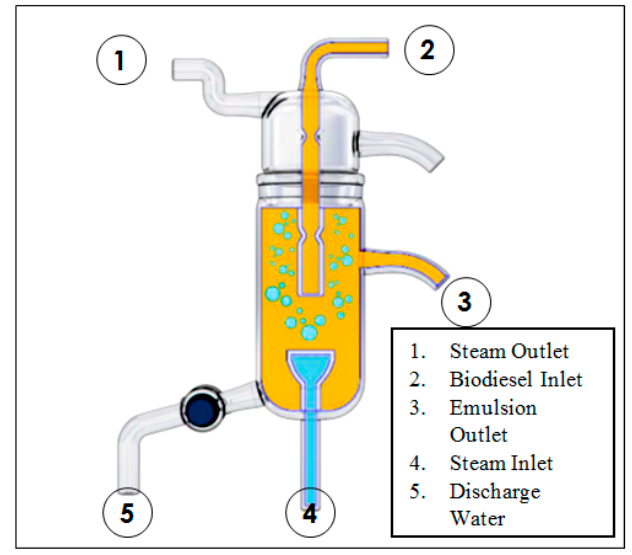
Figure 1. Schematic diagram of the steam emulsification mixing device.